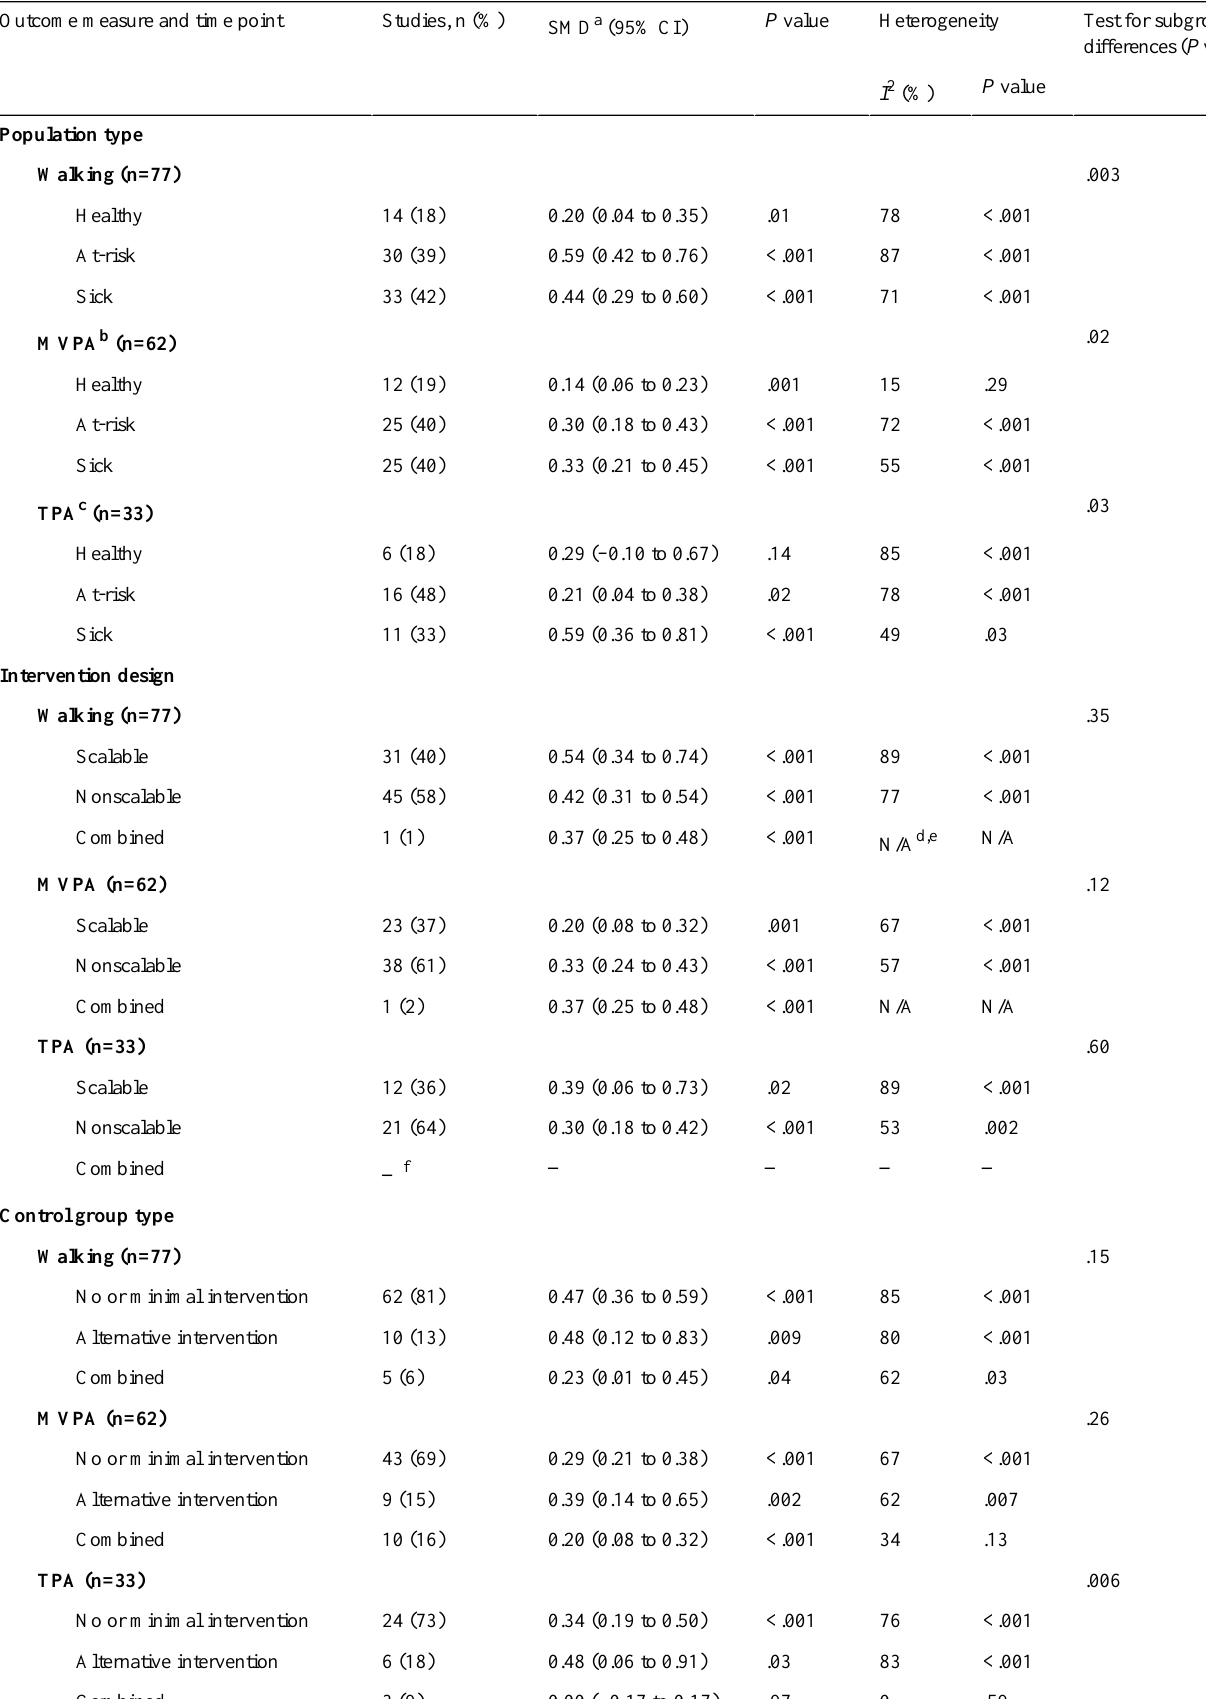
Table 1. Summary of subgroup analyses results.